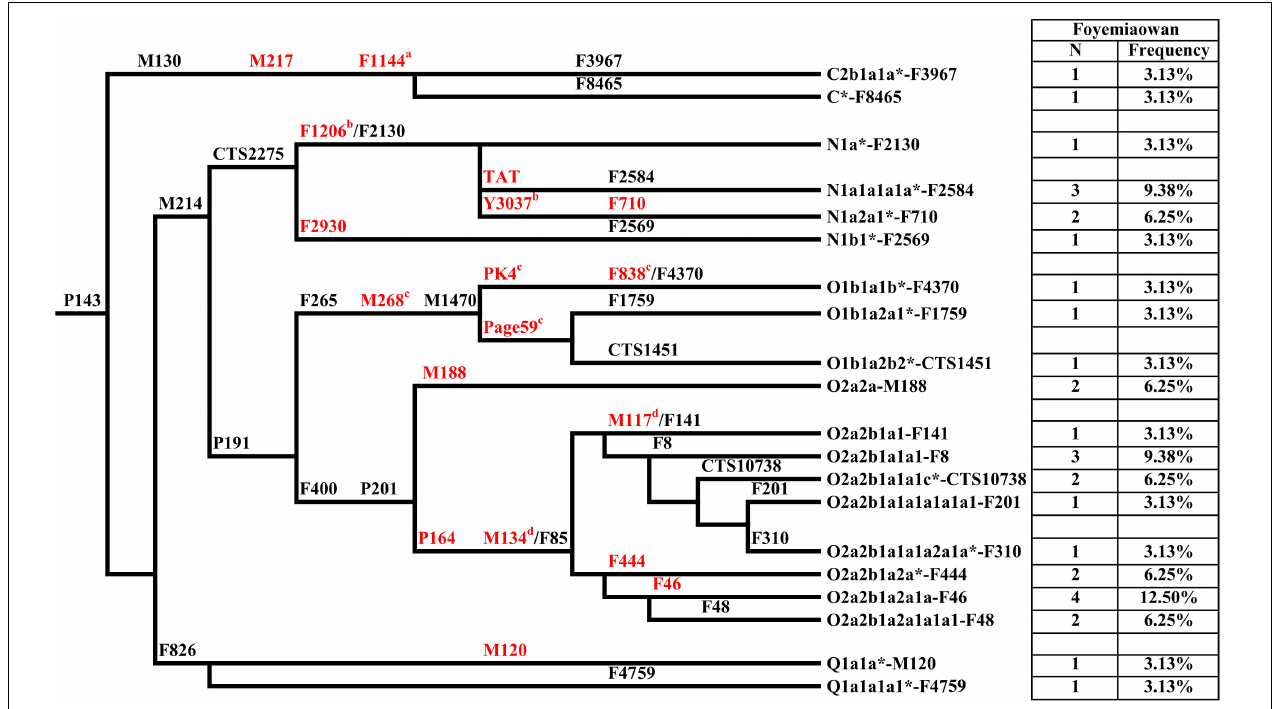
FIGURE 2 | Phylogenetic relationship of Y-chromosome haplogroups in this study, with frequencies are on the right side of the figure. Marker names are shown along the branches and haplogroup names are shown to the right. All Y-chromosome haplogroups are based on the ISOGG-2019. Potentially paraphyletic undefined subgroups are distinguished from recognized haplogroups by the asterisk symbol. Markers in red are key Y-SNPs. a–d: these markers are not designed in the Y-SNP panel but are very common in Y phylogenetic trees.